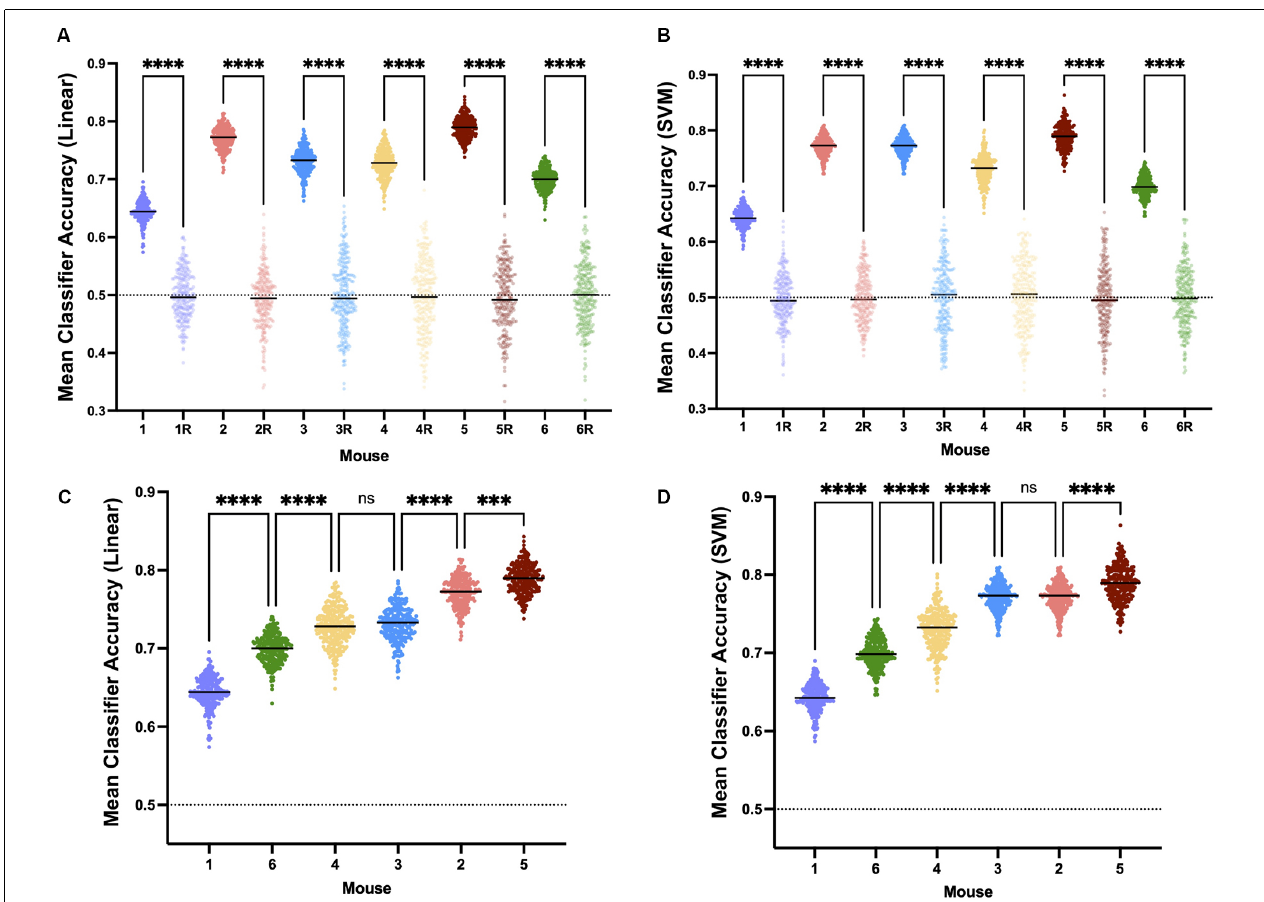
FIGURE 8 | Neural inertia is present in individuals. Individuals show significant neural inertia over the 100 min beginning 30 min after the final 0.6% isoflurane step, as measured by linear classifier accuracy indicating quantifiable distinctions in spectra based on whether the mouse was previously awake or deeply anesthetized. Points represent the mean accuracy over the measured period for a given classifier. Both linear classifiers (A) and support vector machine generated classifiers (B) correctly were able to distinguish induction vs. emergence based on spectral distinctions at a level greater than chance and significantly ( p < 0.0001) more than classifiers using shuffled training data (randomly shuffled data indicated with “R”.) Relative classifier accuracy and differences between individuals were largely conserved across approaches ( C and D , p = 0.4896, Friedman test), suggesting interindividual variability in neural inertia. All comparisons made using